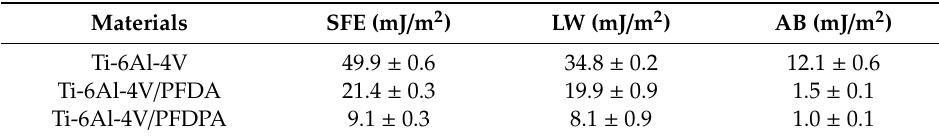
Table 1. Surface free energy and its components for a system consisting of di ff erent SAMs created as a Ti-6Al-4V